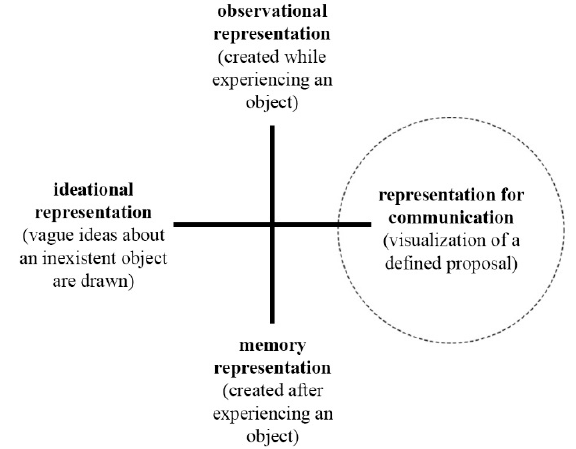
fig. 1. Dichotomies discussed in this chapter; the category on which this article will be focused appears encircled